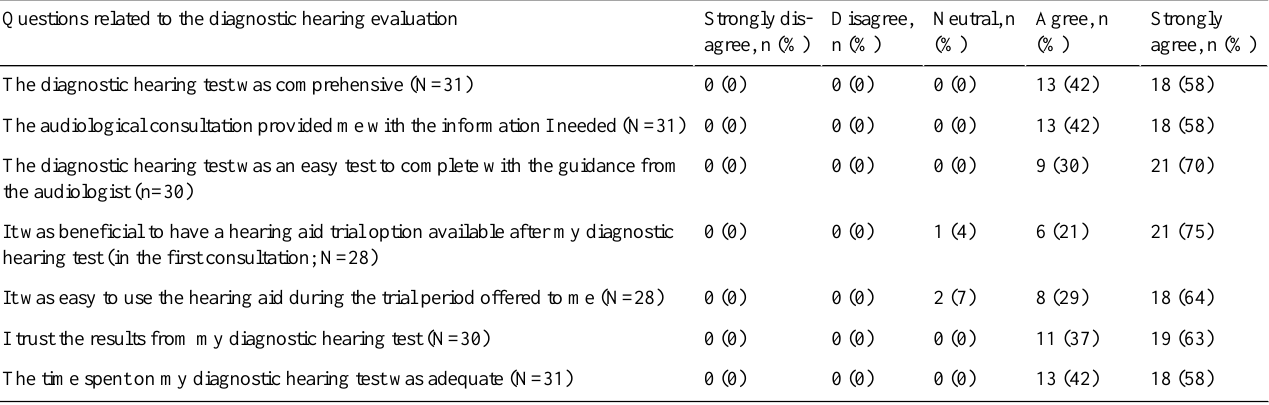
Table 3. Patient evaluation of the diagnostic hearing evaluation.